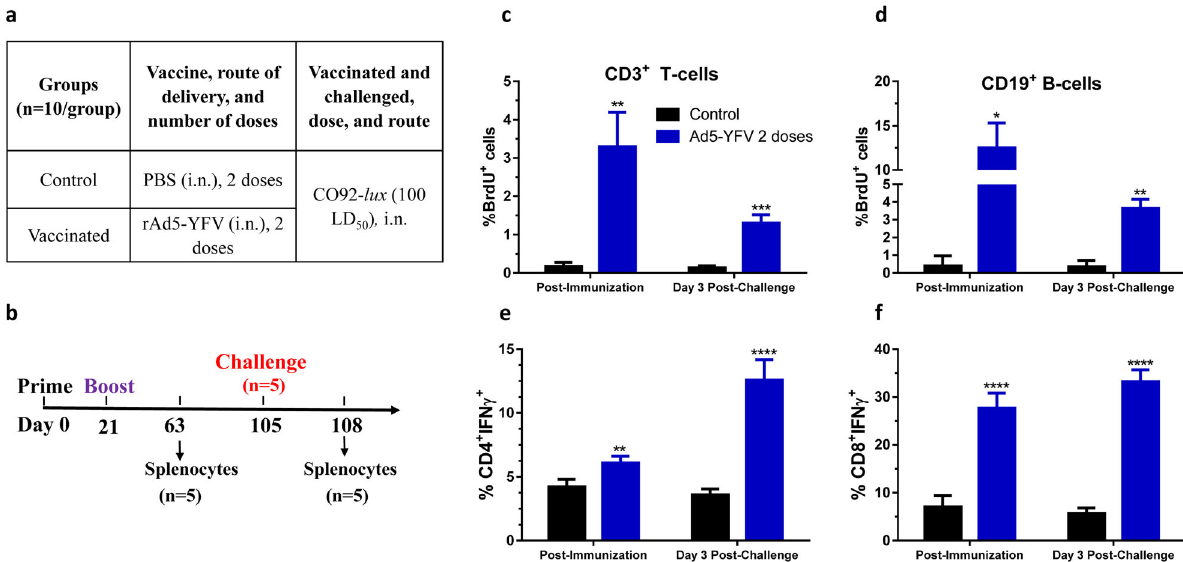
Fig. 6 Cell proliferation and IFN γ production in mice immunized with rAd5-YFV vaccine during long-term study. Mice ( n = 10/group) were immunized (i.n.) twice 21 days apart with rAd5-YFV vaccine ( a ). Forty-two days after the second vaccination (day 63 of the study), spleens were harvested from mice ( n = 5) and also on day 3 post-challenge with Y. pestis CO92- lux ( b ). For cell proliferation study after the second vaccination, mouse splenocytes were stimulated with rF1-V and treated with BrdU for the post-vaccination timepoint ( n = 5) as described in panel b . For the post-challenge timepoint, mice ( n = 5) was i.n. challenged on day 85 after immunization (day 105 of the study) with Y. pestis CO92- lux , and i.p. injected with BrdU ( b ). On day 3 p.i., spleens were harvested and splenocytes were then stained for T- and B-cell surface markers (CD3 and CD19) as well as for incorporated BrdU, and analyzed by fl ow cytometry. The percent of BrdU incorporation in CD3 ( c ) or CD19 ( d ) positive cells was plotted. For IFN γ studies ( e , f ), splenocytes were stimulated with PMA, Ionomycin, and Brefeldin A. Cells were then stained with T-cell surface markers CD3, CD4, and CD8 followed by intracellular IFN γ staining. Percentages of CD4 + IFN γ + ( e ) and CD8 + IFN γ + cells ( f ) were shown. Student ’ s t -test was used to determine statistical signi fi cance between T-cell population from control and rAd5-YFV vaccinated groups. Asterisks above columns represent comparison to the control group. * P < 0.05, ** P < 0.01, *** P < 0.001, **** P < 0.0001. Two biological replicates were performed, and data